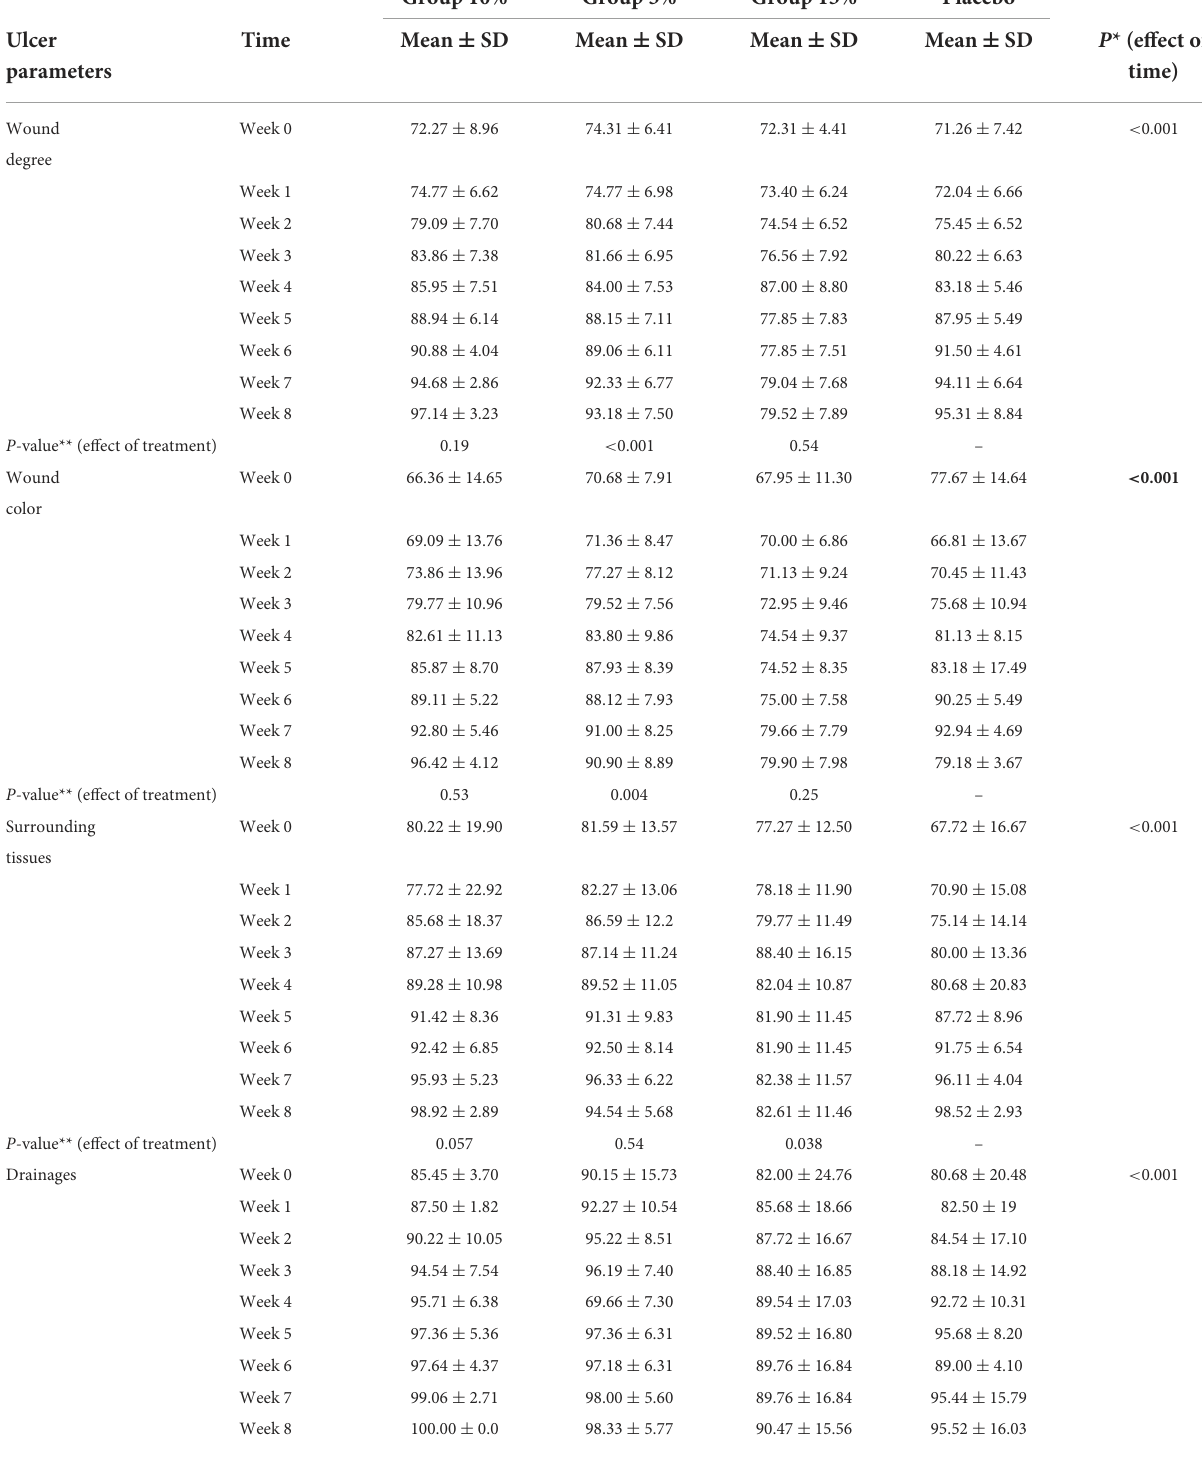
TABLE 3 Comparison of mean and standard deviation of ulcer parameters and total ulcer status from week 0 to 8 in 4